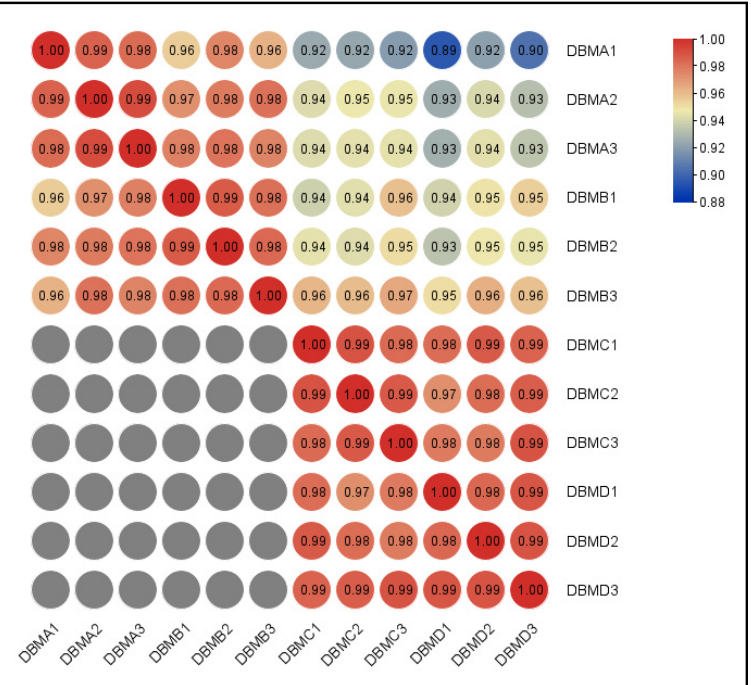
Figure 3. Pearson correlation coefficient heat map of gene expression between different samples. DBMA1, DBMA2, DBMA3: three biological repetitions from the susceptible strain (G88); DBMB1, DBMB2, DBMB3: three biological repetitions from the susceptible strain with toxin treatment (G88 + toxin); DBMC1, DBMC2, DBMC3: three biological repetitions from the resistant strain (Cry1S1000); DBMD1, DBMD2, DBMD3: three biological repetitions from the resistant strain with toxin treatment (Cry1S1000 + toxin).